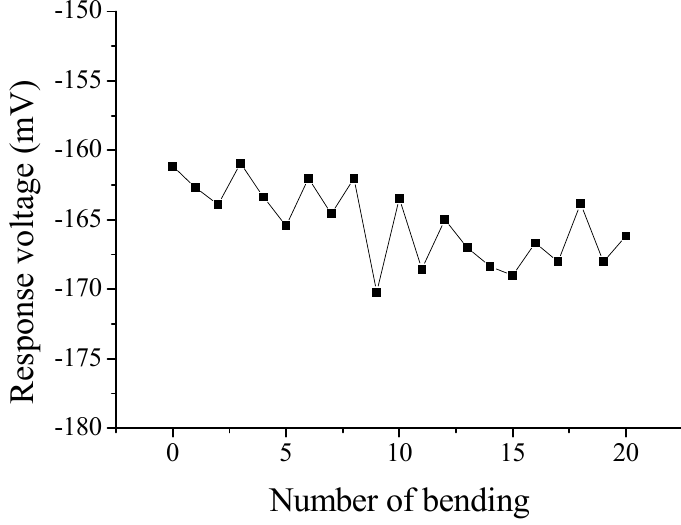
Figure 11. The variation on response voltage of flexible arrayed lactate biosensor after bending 20 times.